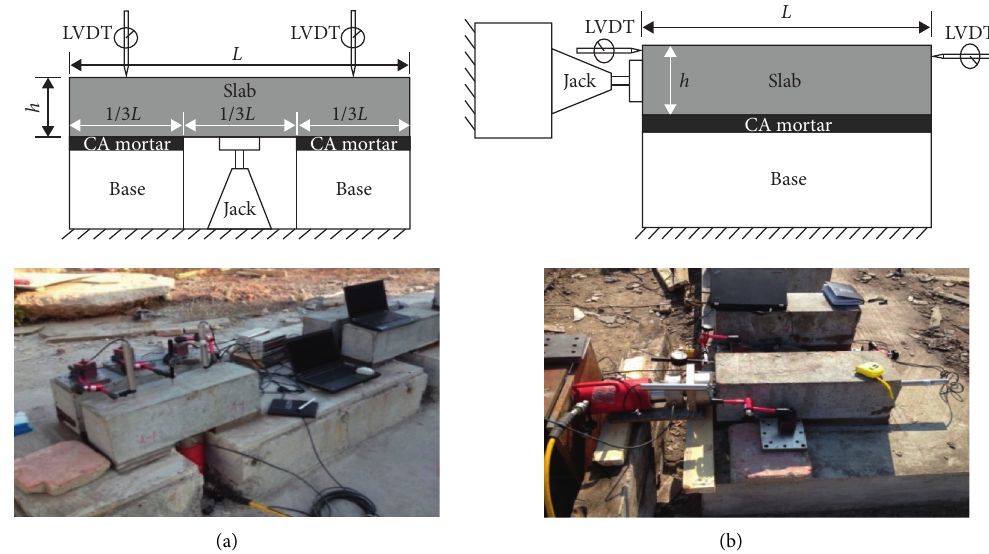
Figure 6: Scheme and setup of the scale push plate tests. (a) Scale vertical push plate test. (b) Scale horizontal push plate